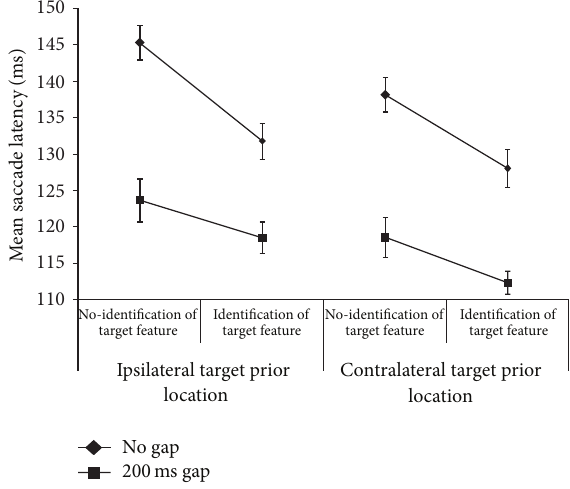
Figure 4: Mean saccadic latencies for 𝑛 = 20 collapsed across eccentricities. Main effects and interactions are described in the text: note the three-way interaction for gap × identification × target prior location. Error bars = ± 1